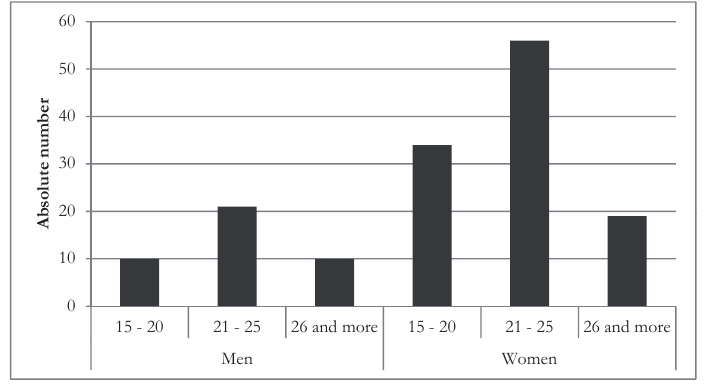
Fig. 4 - Absolute numbers of men and women by age. Source: own processing,